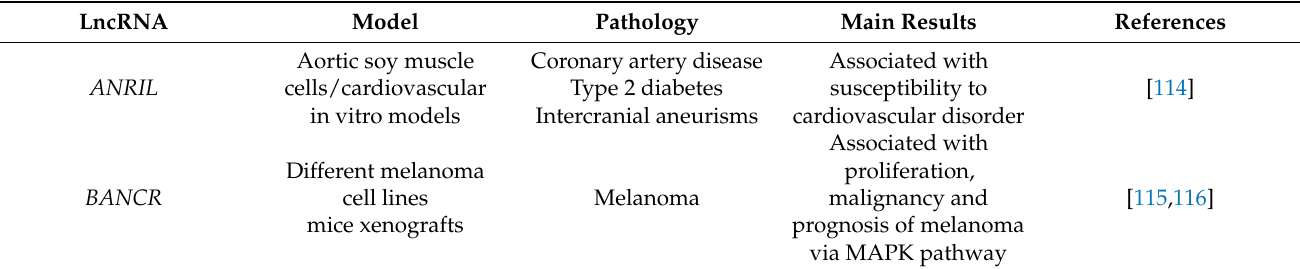
Table 3. LncRNAs role in immunity related